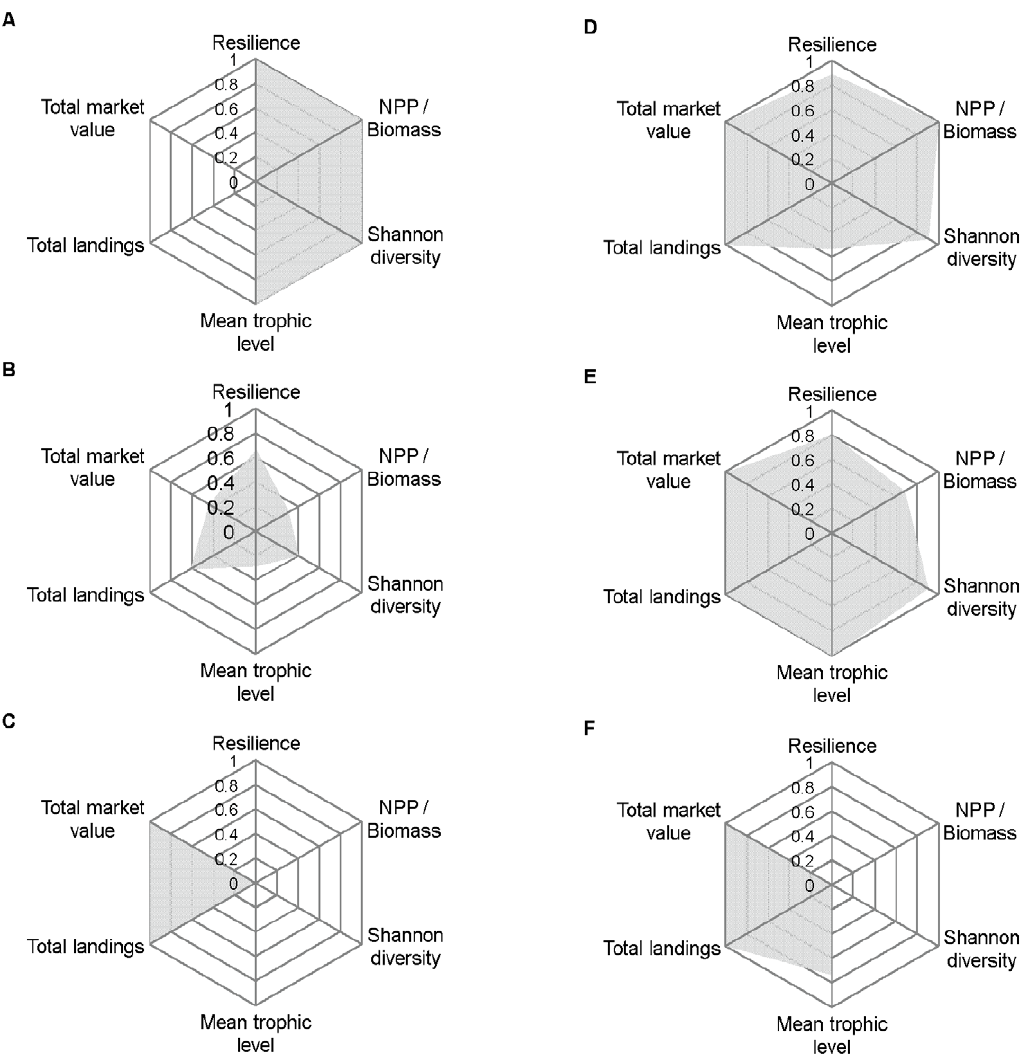
Figure 4. Spider plots depicting trade-offs among four ecosystem attributes and two fisheries yield metrics. The three different fishing (a-c) and nearshore habitat (d-f) pressure levels corresponded approximately to a minimum-impact scenario in which none of the utility thresholds were breached (a, d), a threshold scenario in which the simulated pressure matched that of the lowest utility threshold (median value; see Table 2) (b, e), and a maximum-impact scenario representing the maximum pressure considered (c, f). Note that for each type of pressure, all attributes have been re-scaled so that values are relative and fall within the interval [0,1], where zero corresponds to a stressed condition and one corresponds to an unstressed